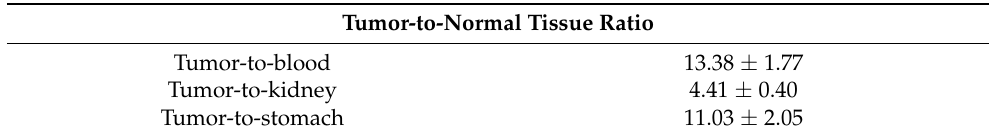
Figure 6. Biodistribution profile of [ 68 Ga]Ga-DOTA-MGS8 in A431-CCK2R/A431-mock xenografted female BALB/c nude mice at 1 h p.i. ( n = 4). Values are expressed as % IA/g. Table 3. Tumor-to-normal tissue ratios for [ 68 Ga]Ga-DOTA-MGS8 in A431-CCK2R xenografted female BALB/c nude mice at 1 h p.i. ( n =